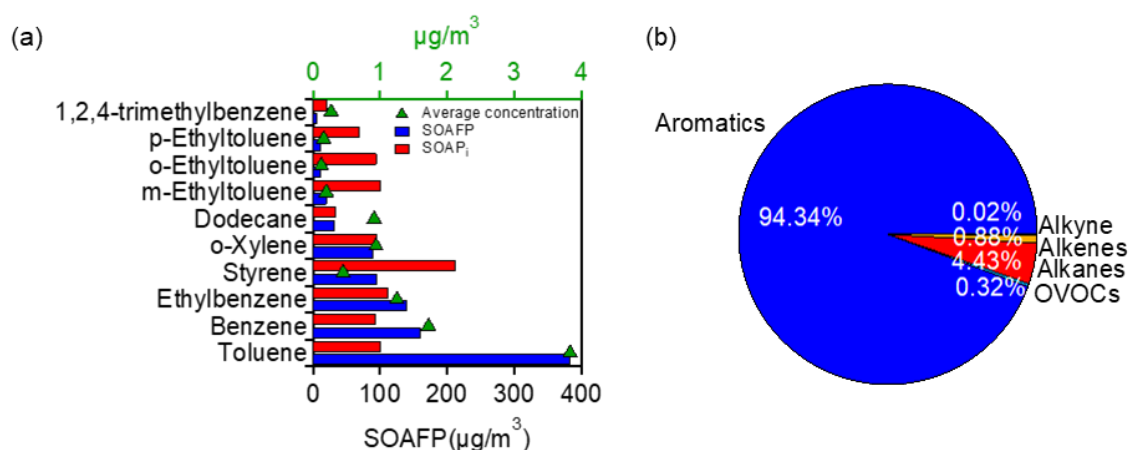
Figure 6. ( a ) Top 10 species of SOAFP (as well as their SOAP values and average concentrations), and ( b ) relative contributions of different VOCs to the SOAFP.